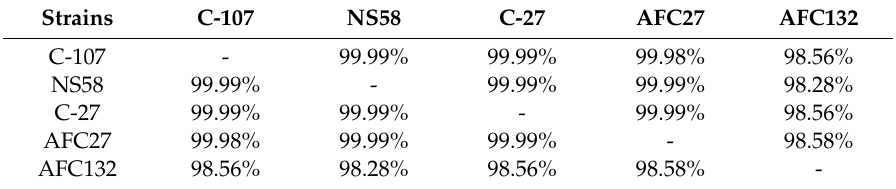
Table 2. Two-way average nucleotide identity (ANI) analysis of Nitrosococcus oceani genomes. Strains C-107 NS58